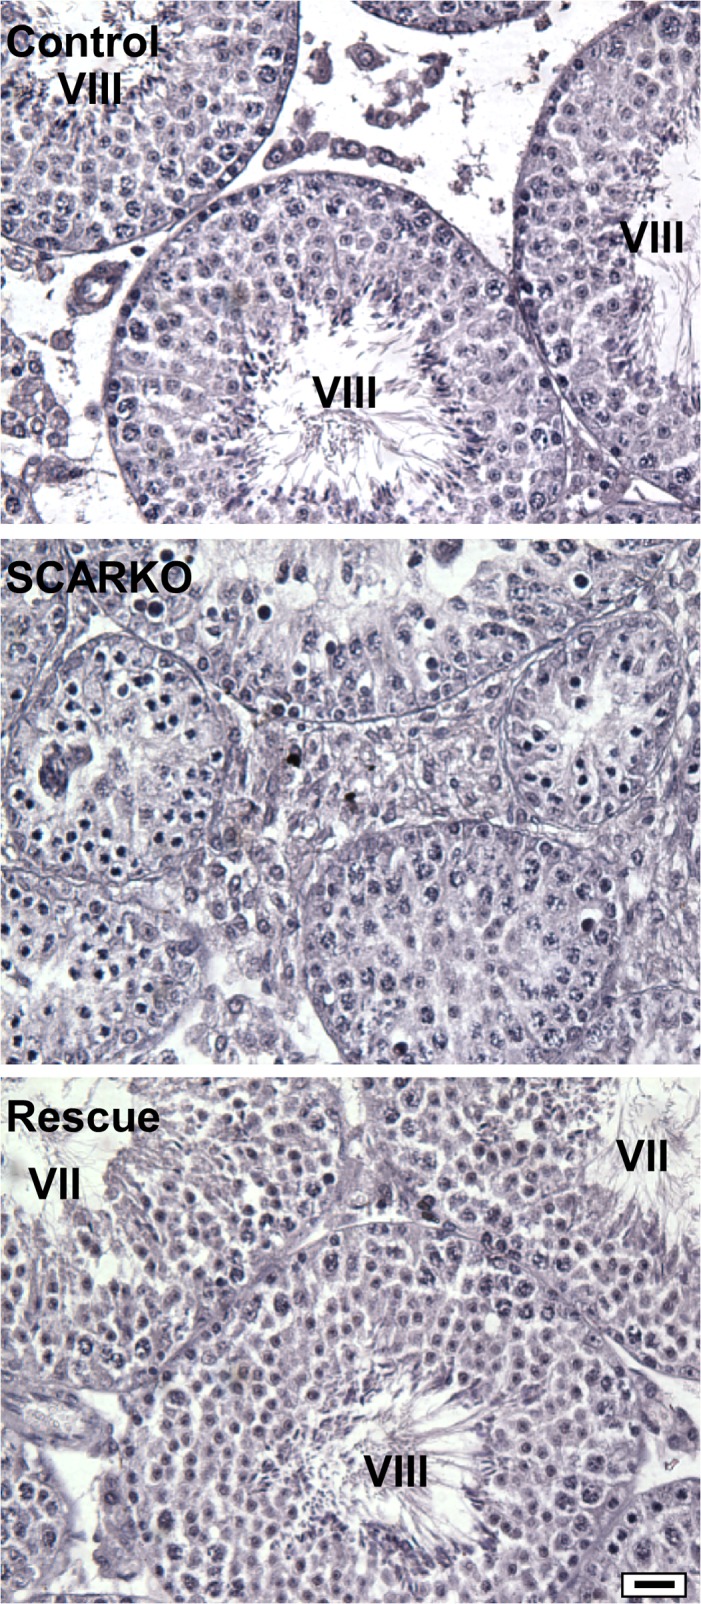
Expression of the AR-EGFP transgene rescues full spermatogenesis in a SCARKO background.Testes cross sections stained with PAS-Hematoxylin are shown for postnatal day 105 mouse littermates (founder 2464) that express only Cre recombinase (Control), Cre recombinase in the presence of a floxed AR gene (SCARKO), and a SCARKO mouse expressing the AR-EGFP transgene (Rescue). Bars = 100 μm, magnification: 40x objective.